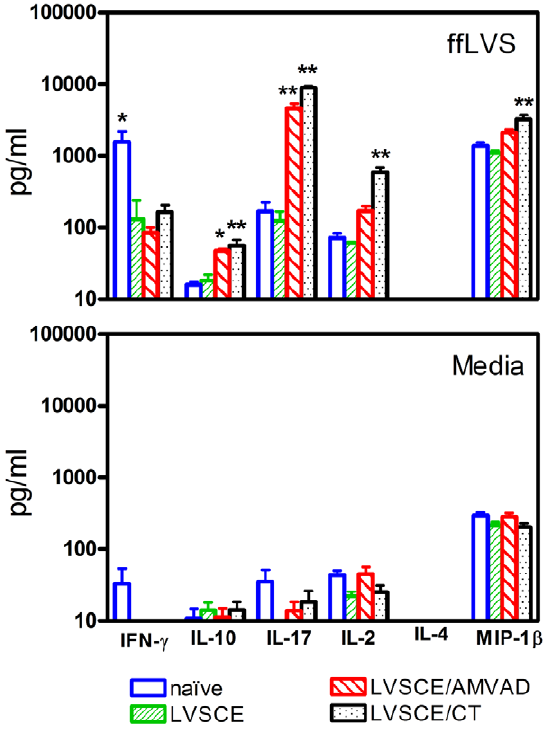
Figure 3. LVSCE/AMVAD vaccine induces production of cytokines by splenocytes. Splenocytes (2.5 6 10 6 cells/ml) obtained from the naı¨ve, and LVSCE, LVSCE/AMVAD or LVSCE/CT immunized mice euthanized at 28 d in Figure 1 experiment, were stimulated in vitro for 48 h (37 u C, 5% CO 2 ) in the presence of formalin-fixed F. tularensis LVS (ffLVS; 2 6 10 6 cells/ml). The supernates were collected and assayed for various cytokines. Supernates collected from the respective splenocytes stimulated with media only were the negative controls, and those collected from splenocytes stimulated with Concanavalin A (data not shown) were the positive controls, respectively, for the assay. The data are presented as mean 6 SD for each group (n=5) of naı¨ve, and LVSCE, LVSCE/AMVAD or LVSCE/CT immunized mice. * p , 0.05 and